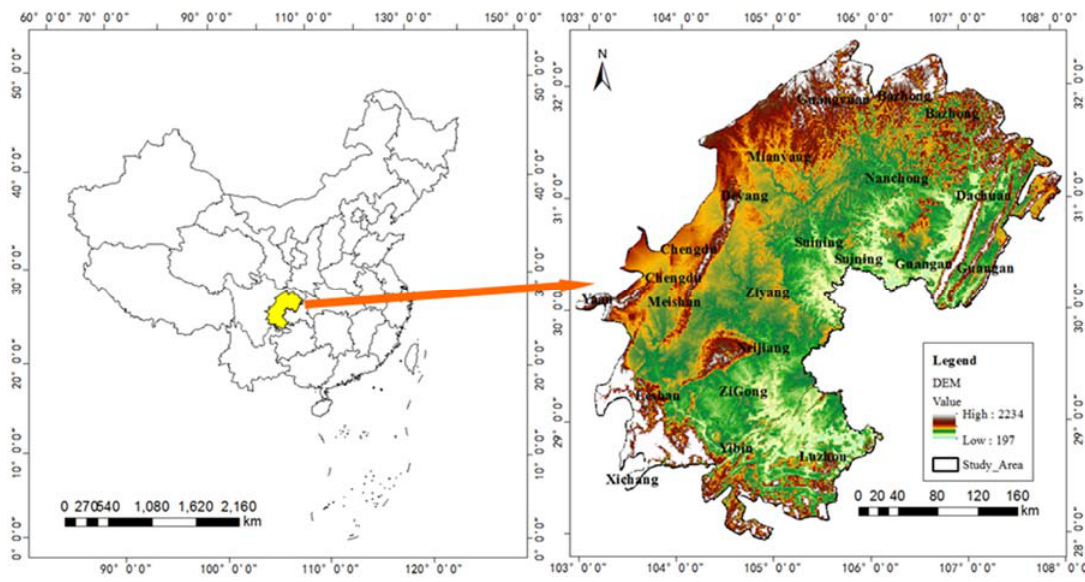
Figure 1. Map of the distribution of hills in Sichuan.